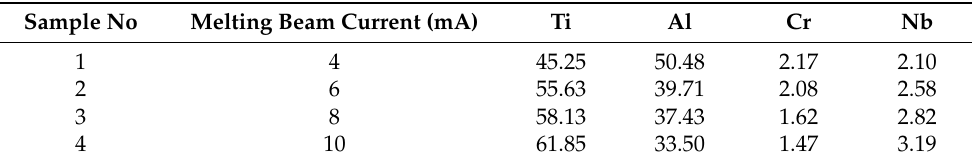
Table 2. Chemical composition of as-built samples (atomic percentage) [89]. Sample